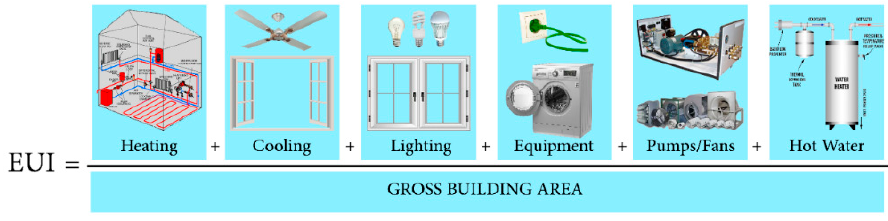
Figure 3. Energy use intensity in residential buildings.